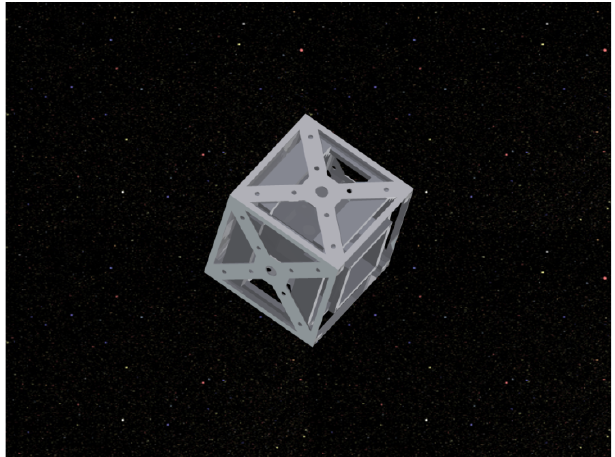
Figure 11. CAD Diagram of OpenOrbiter Satellite Internal